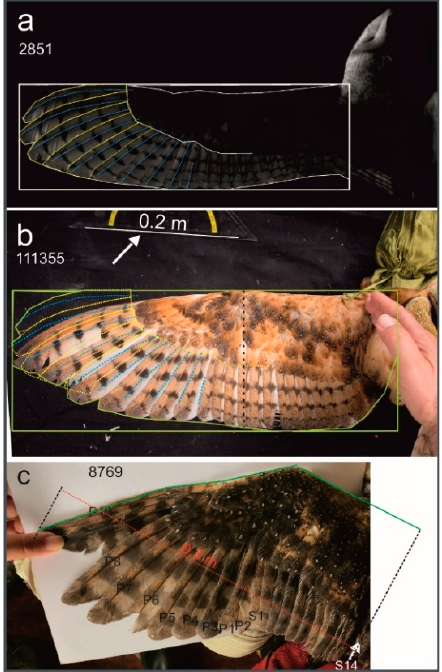
Figure 1. Methods to reconstruct wing parameters. ( a ) Image extracted of a video that shows wing spreading as it occurs in flight ( T.f.pratincola ). The distal primaries and the rachises are marked in yellow and blue, respectively. ( b ) Wing of a living T.f.pratincola that was stretched while held by hand. Note that the distal primaries were not appropriately spaced, as may be seen by comparing the marked feather outlines taken from ( a ). The arrow points to the ruler that was used for scaling (white line corresponds to 0.20 m). The dashed black line represents chord length. ( c ) Photograph of a wing of a T.f.punctatissima . The wing was measured with a ruler (indicated by the red line) to have a length of 0.3 m. The different segments (green lines) and their addition demonstrated that veriical wing length was 0.364 m. The black dashed line on the right outlines the orientation of the body and the base of the wing. Px: primaries, Sx: secondaries; 2851, 111355, 8679: identification codes for the photos.